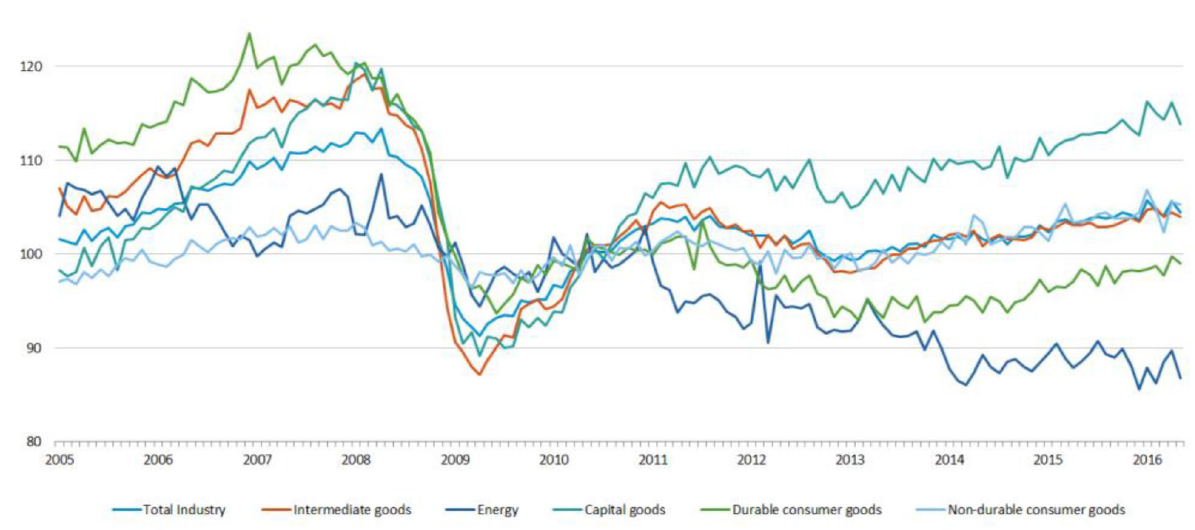
Figure 1. Industrial Production Volume rate between 2005-2016 (Eurosat,